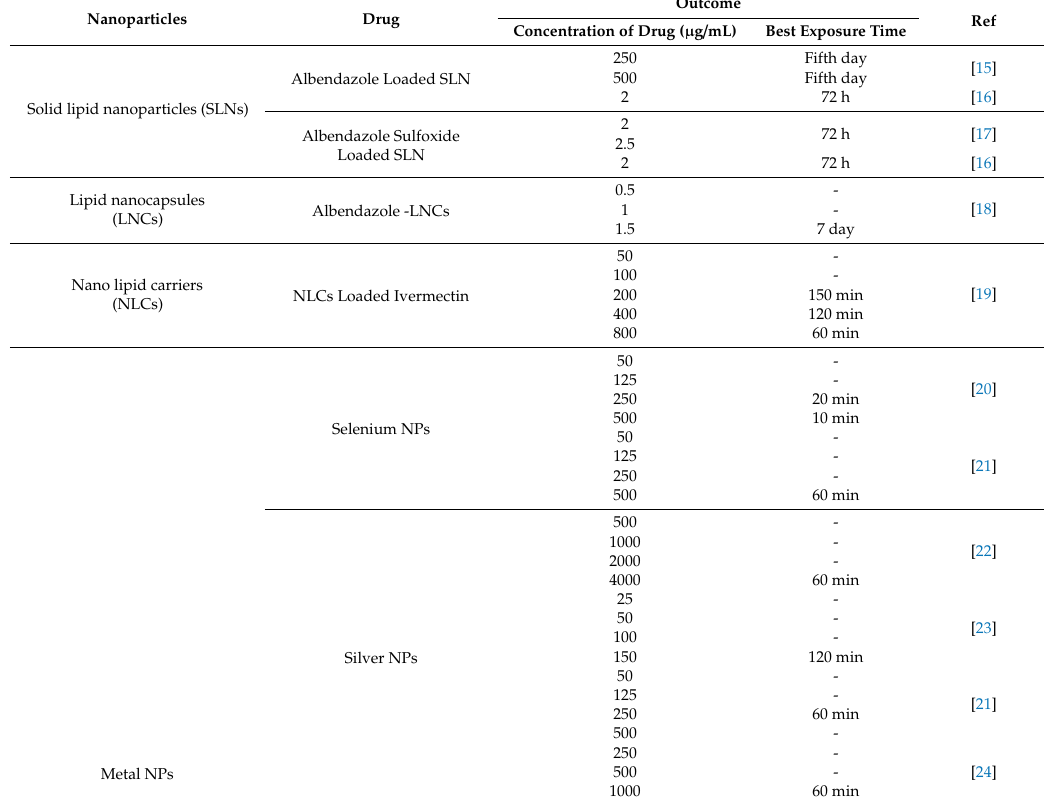
Table 1. A list of in vitro studies on e ff ects of nanoparticles against hydtid cysts.